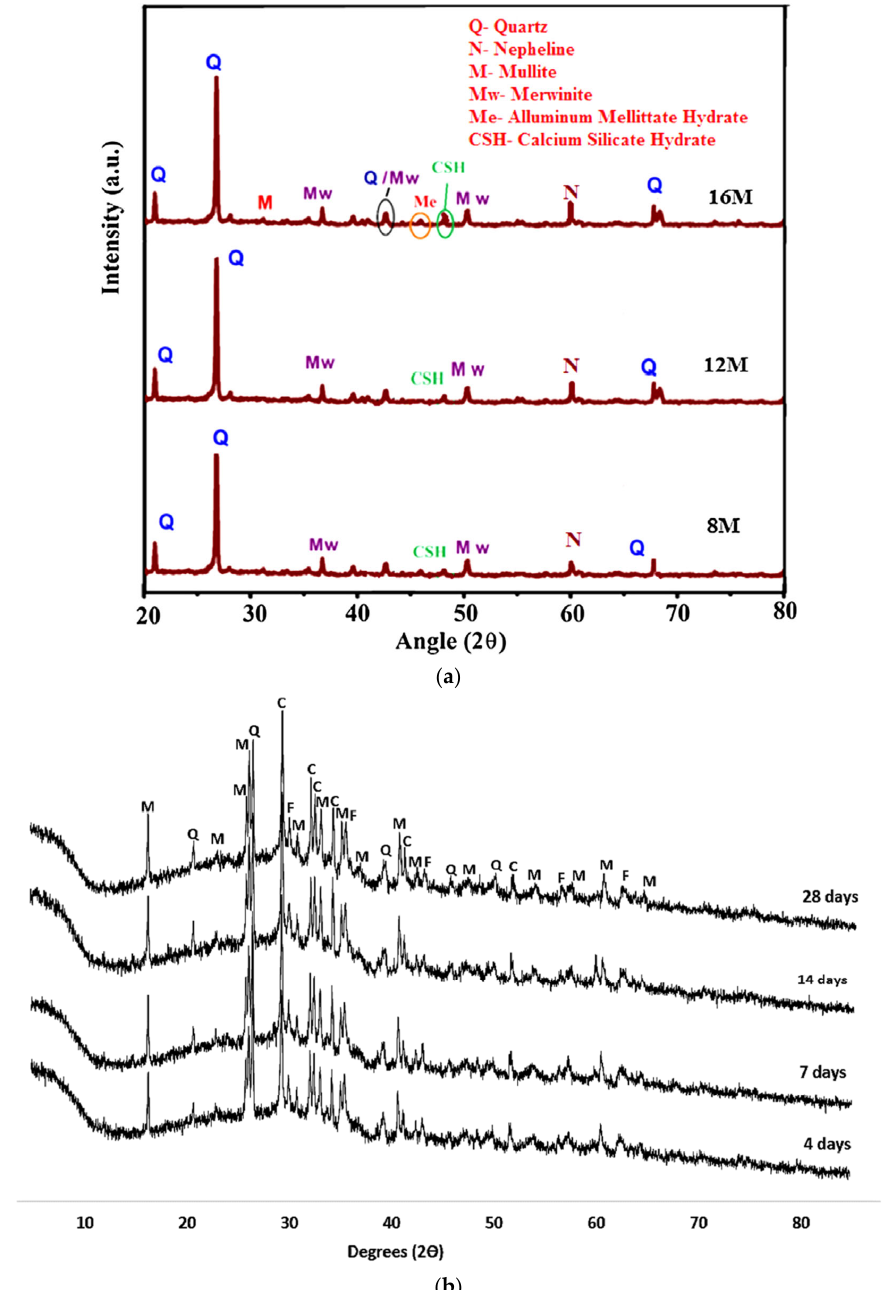
Figure 24. XRD pattern of FA ‐ GP concrete specimen at different ( a ) molarities after 28 days and ( b ) ages. Adapted from [258,262].